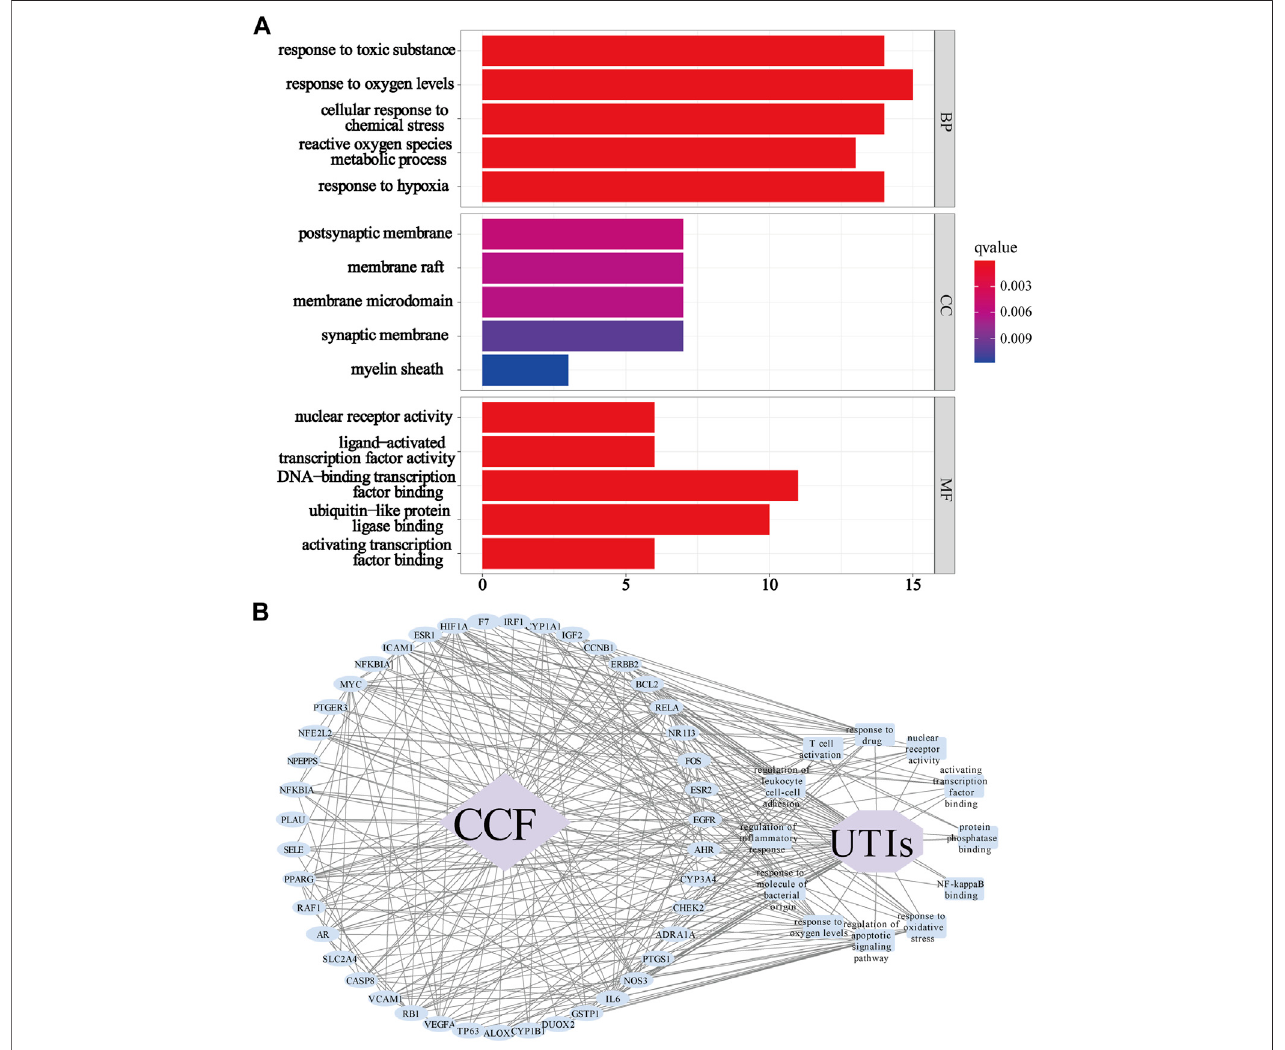
FIGURE6| GOenrichmentanalysisfortheidenti fi edgenes. (A) GOanalysisshowingthebiologicalprocess,cellular component, andmolecularfunction;Eachbar represents a GO term on the y -axis, while the horizontal axis indicates the number of proteins enriched in each term. The color shows the adjusted p -value of each GO term. The bluer the color of the term, the smaller the p adjusted value. ( B) Target-biological function network. The blue ellipse nodes refer to the targets, the blue round rectanglesshowthepickedbiologicalfunctionsorsignalingpathways,thepurpleoctagonmeansthedisease,thepurplediamondindicatesthedrug,andtheblack lines represent the